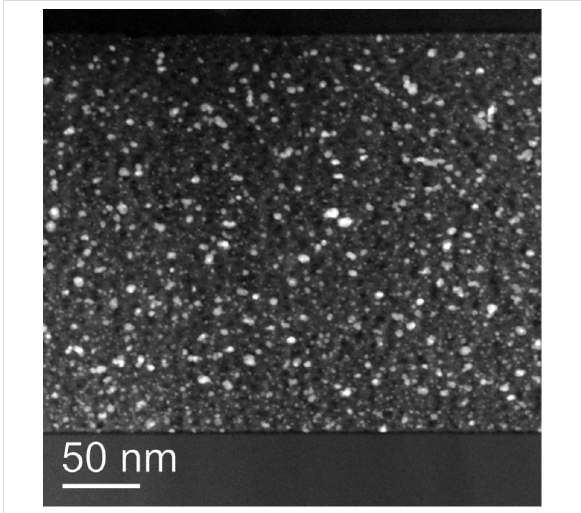
Figure 4: Cross-sectional scanning TEM image of a mesoporous Au/TiO 2 film spin-coated onto a Si(100) wafer and subsequently loaded with